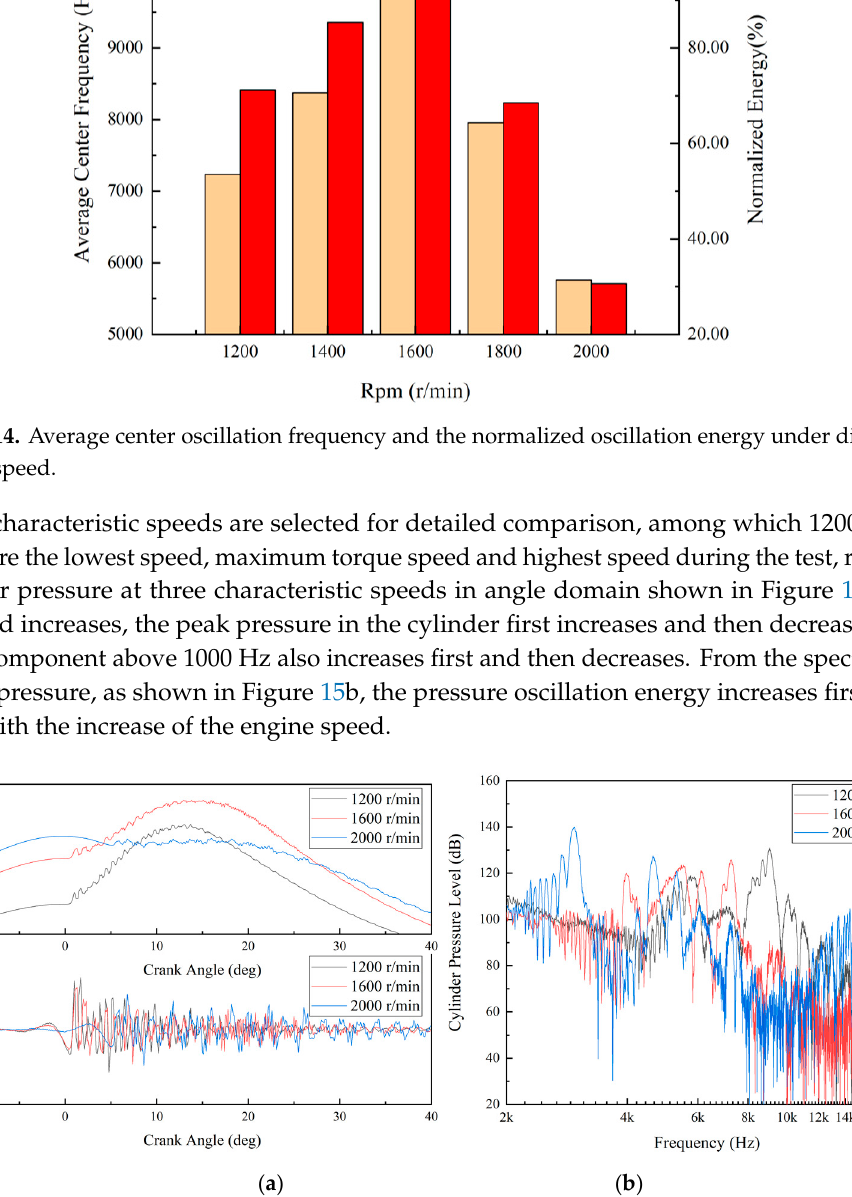
Figure 15. In-cylinder pressure at different engine speeds: ( a ) in angle domain; ( b ) infrequency domain.